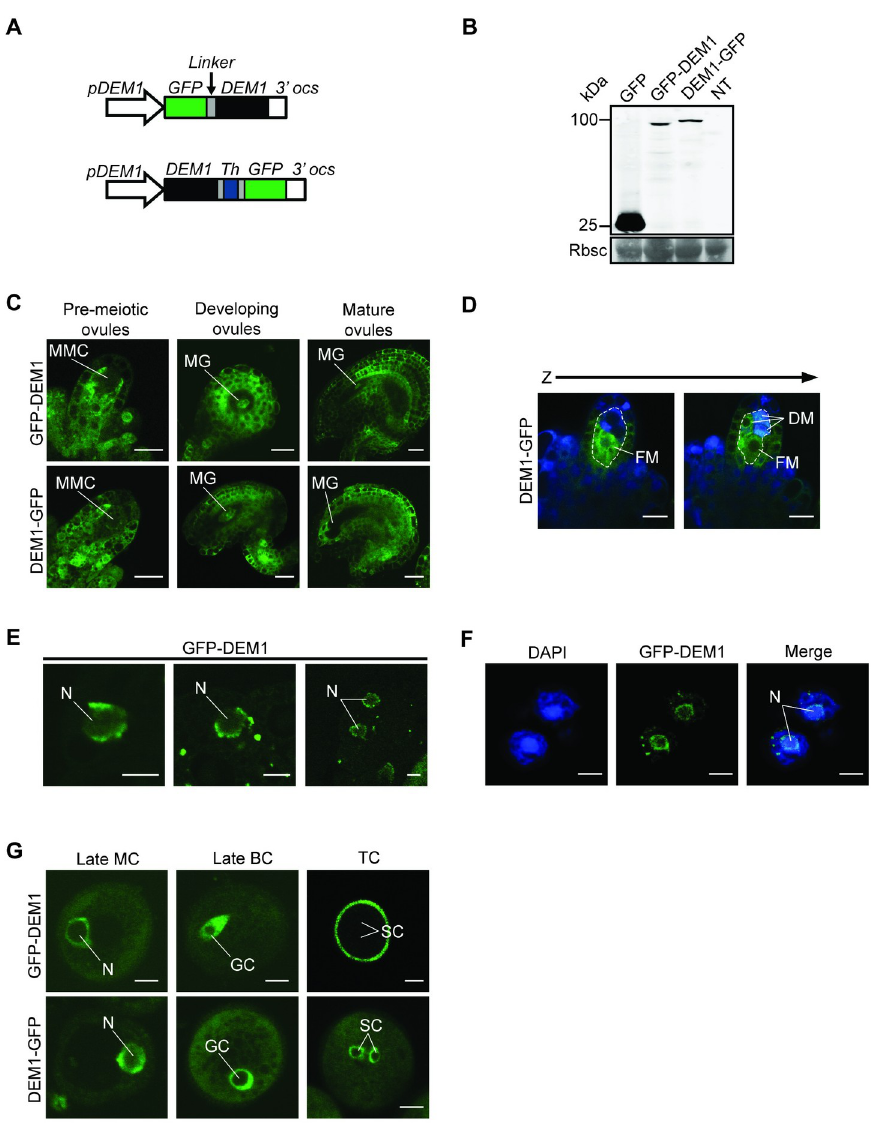
Fig 7. GFP-tagged DEM1 is expressed in developing gametophytes and sporophytic tissues of Arabidopsis . (A) Transgenes used to express DEM1 N-terminal or C-terminal GFP fusion proteins under the control of the DEM1 promoter ( pDEM1 ). The coding sequence for six alanine residues ( Linker ) were inserted between GFP and DEM1 of pDEM1 : GFP-DEM1 . Similarly, the pDEM1 : DEM1-GFP transgene contained the coding sequence for three alanine residues, followed by a thrombin cleavage site and three more alanine residues ( Th ). (B) Anti-GFP western blot on floral bud extracts of 35S : GFP (GFP), pDEM1 : GFP-DEM1 (GFP-DEM1) and pDEM1 : DEM1-GFP (DEM1-GFP) transgenic lines, and a non-transgenic control (NT). Molecular weight is indicated in kDa. The molecular masses of GFP-DEM1 and DEM1-GFP are approximately 100 kDa, and of GFP is 27 kDa. The Coomassie Brilliant Blue-stained (CBB) membrane shows Rubisco (Rbsc) as a loading control. (C) Ubiquitous and punctate GFP-tagged DEM1 expression in ovules prior to meiosis (pre-meiotic ovules), and in developing and mature post-meiotic ovules. In pre- meiotic ovules, very little GFP fluorescence could be seen in the megaspore mother cell (MMC), whereas high expression was observed in the sporophytic cells surrounding the MMC (bar = 10 μ m). In developing ovules, high GFP expression is observed in the sporophytic tissue and in the megagametophyte (MG) (bar = 20 μ m). In mature ovules, high GFP fluorescence was observed in the sporophytic tissues, but very little expression was seen in the megagametophyte (MG) (bar = 20 μ m). (D) Two optical sections (Z-stack) showing high expression of DEM1-GFP in the functional megaspore (FM) of an ovule (bar = 10 μ m). DM, dead megaspores. (E) Expression of GFP-DEM1 in male pre-meiotic cells; GFP-DEM1 localized around the nuclear envelope (bar = 5 μ m). N, nucleus. (F) Expression of GFP-tagged DEM1 was also detected in meiotic products of male meiosis; two cells of a tetrad are shown in the figure. Note the subcellular localization of GFP-DEM1 around the nuclear envelope relative to the DAPI stained nucleus